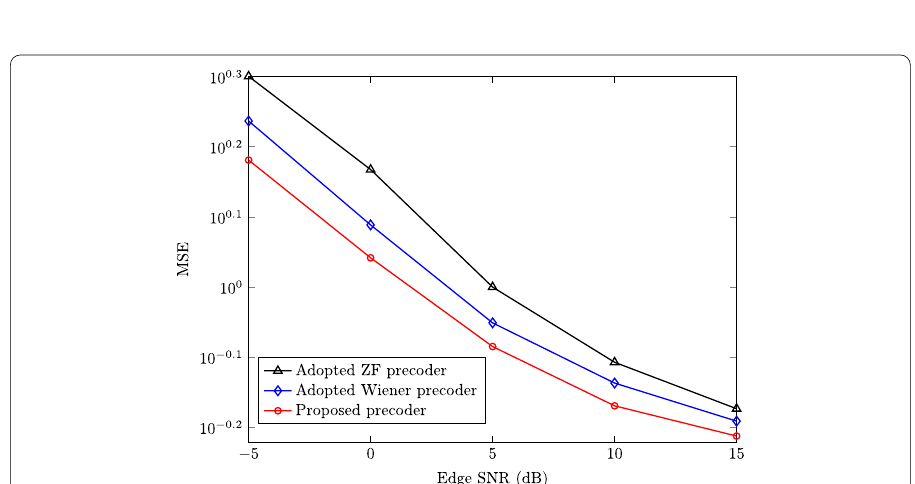
Fig. 6 Performance of the adopted ZF, adopted Wiener and the proposed precoders in terms of MSE in SFB-CBH configuration with r fl = r bl = 0.33, N t = 1 . The channel is time-variant with △ t = 1 ms and v = 5 km /